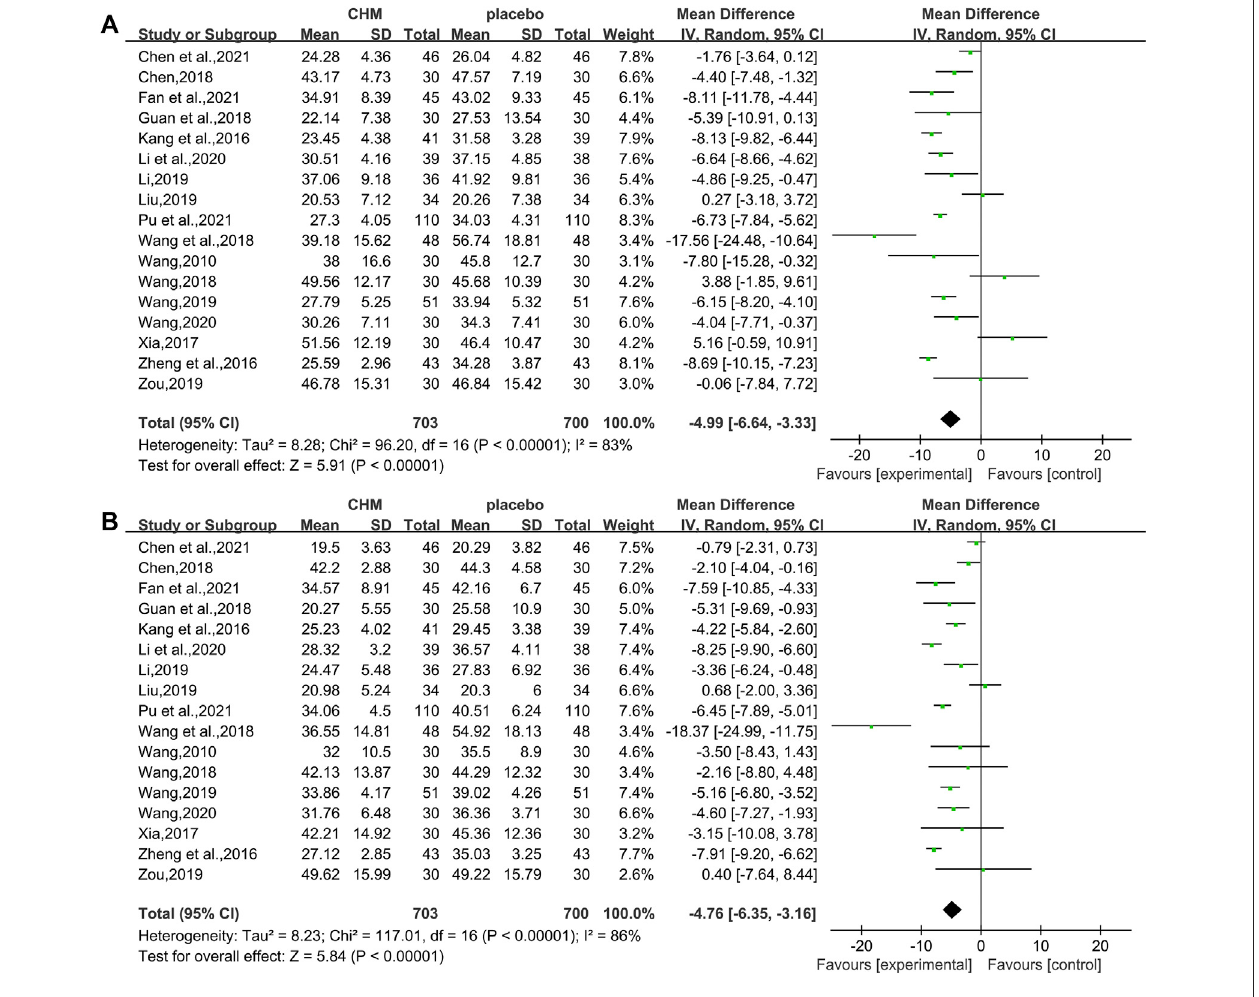
FIGURE 5 | Forest plot for liver functions. (A) ALT and (B)